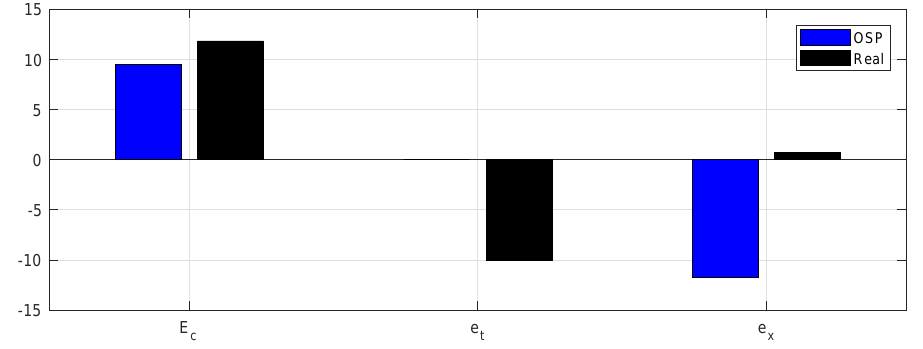
Figure 15. Case C—Real (black) and simulated (blue) energies (kWh), traveling times (s) and distance errors (m).